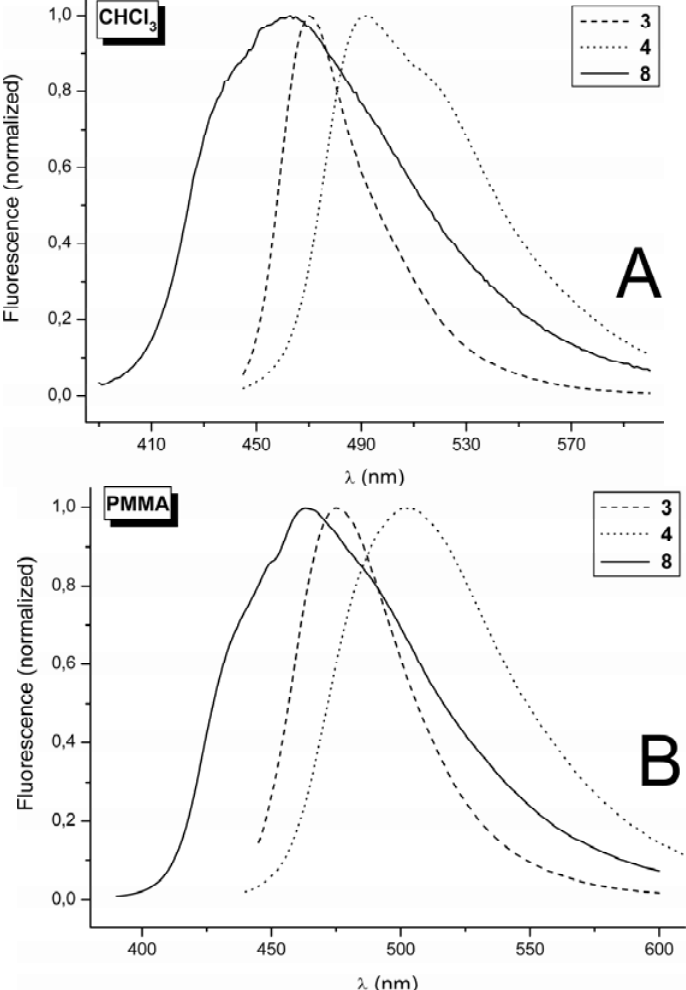
Figure 3. ( A ) Fluorescence spectra of 3 , 4 and 8 in CHCl ( B ) Fluorescence spectra of 3 , 4 and 8 in PMMA at 0.002 mol kg − 1